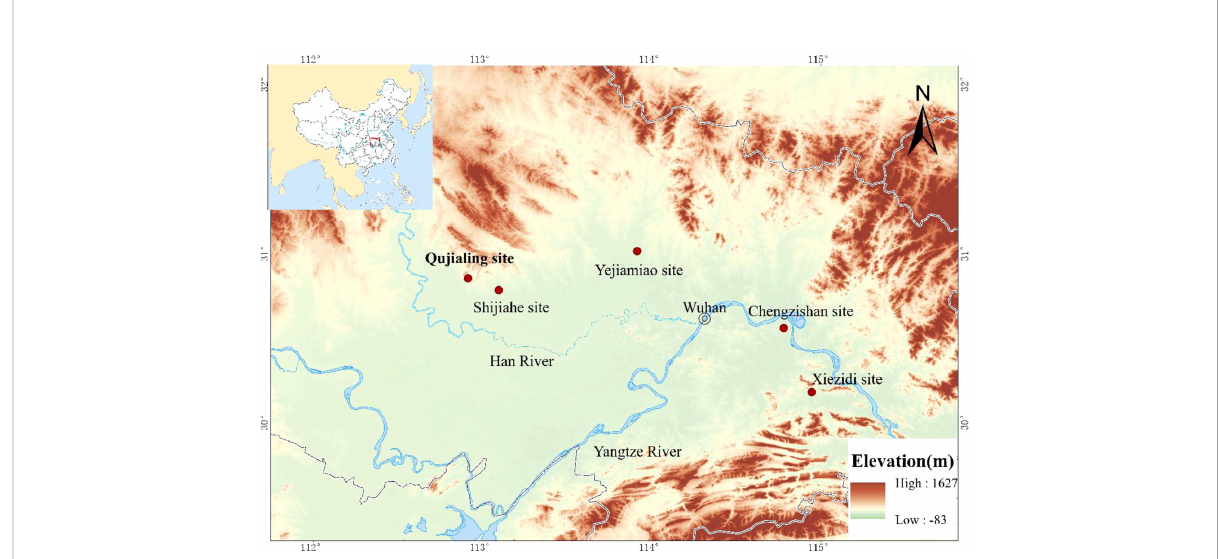
FIGURE 1 Locations of Qujialing and nearby sites in the middle catchment of Yangtze